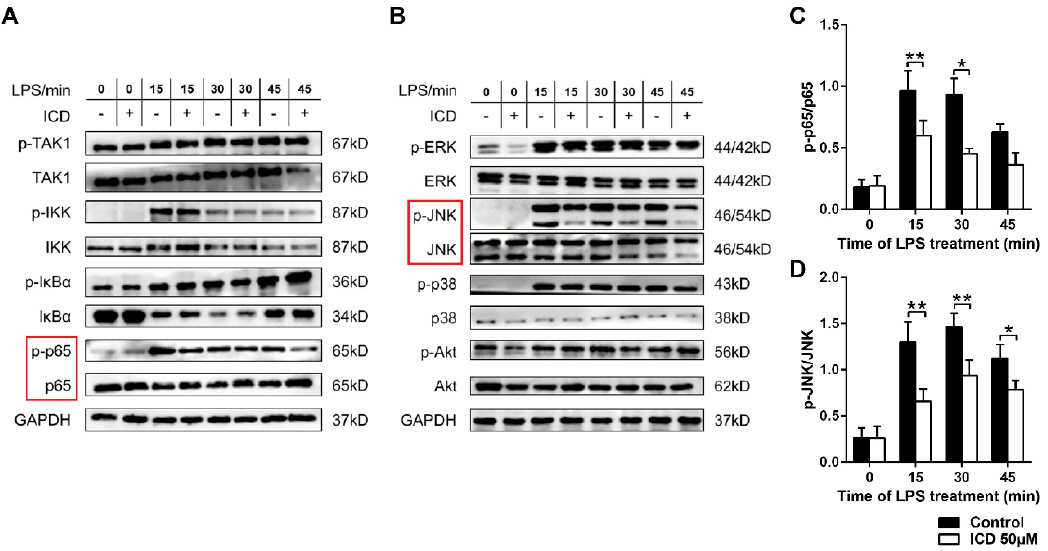
Figure 5. ICD reduces the activation of LPS-induced inflammation-related signaling pathway in bone marrow-derived macrophages. ( A , B ) Western blot analysis activation of NF-kB and MAPK signaling pathway in macrophages stimulated with LPS at different time points as indicated, pretreated with ICD or not. The ratios of p-p65/p65 ( C ) and p-JNK/JNK ( D ) were quantified with ImageJ software (v1.53). The mean and SD of at least three independent experiments are shown. * p < 0.05, ** p < 0.01 indicate significant differences between groups, as determined by a two-tailed paired Student’s t -test.